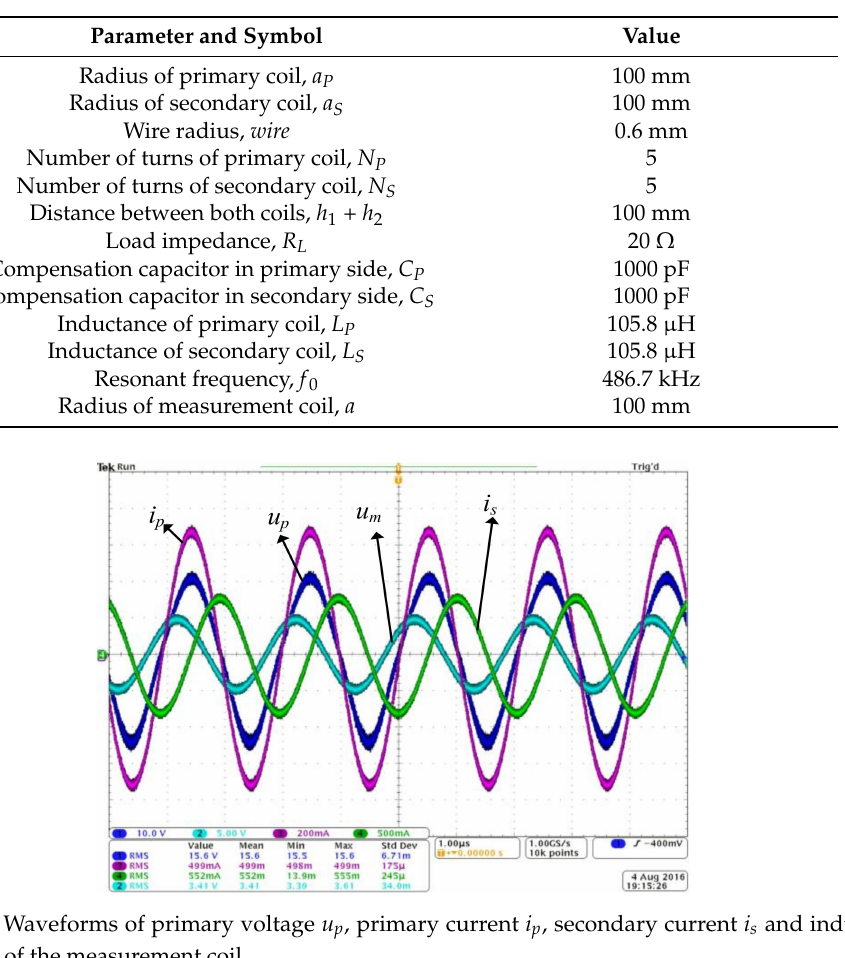
Table 1. Experimental parameters.